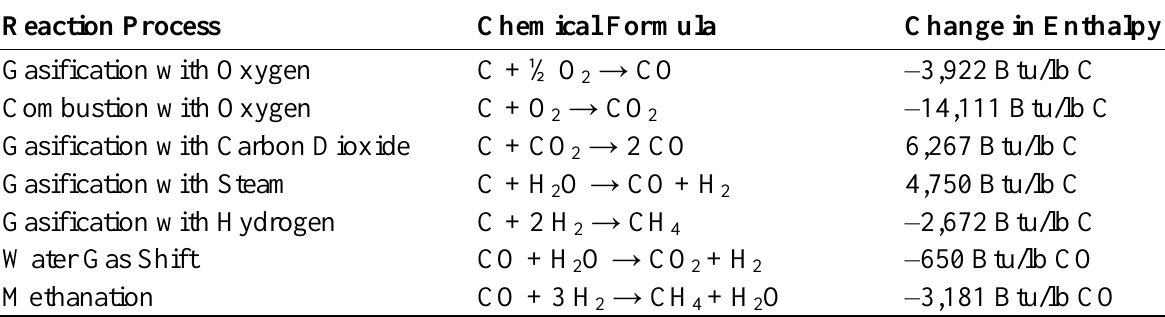
Table 1. Gasification and Combustion Chemistry.